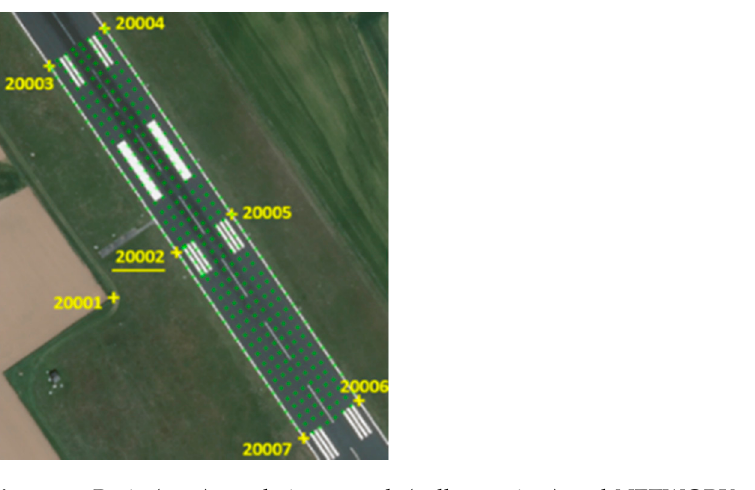
Figure 1. Basic (zero) geodetic network (yellow points) and NETWORK on the runway (green points) [56].